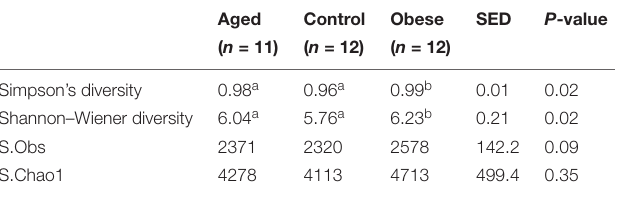
TABLE 4 | Diversity and richness indices for fecal bacterial communities across host phenotypic groups. Aged Control Obese